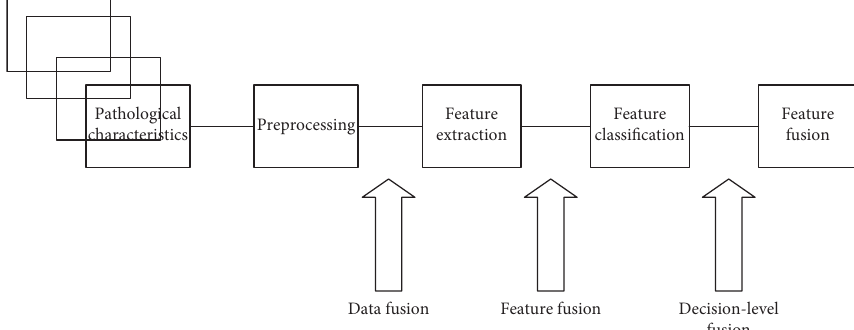
Figure 6: Fusion test of pathological characteristics.